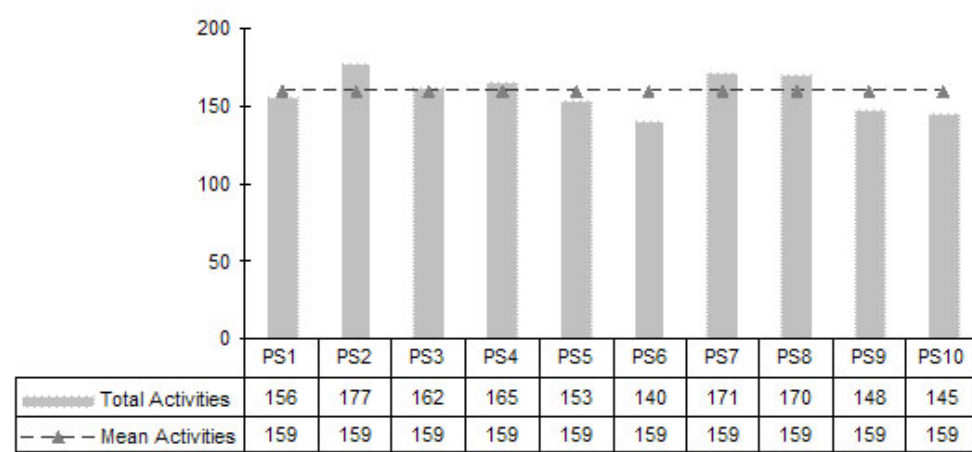
Figure 2. Participant Instructors’ Responses to Learning